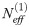
EWS for γ = 2.While the natural state of the system N(1) (blue) shows no EWS (both standard deviation and autocorrelation decrease), the EWS are clearly visible for the effective state Neff(1) (green) in networks with γ = 2.